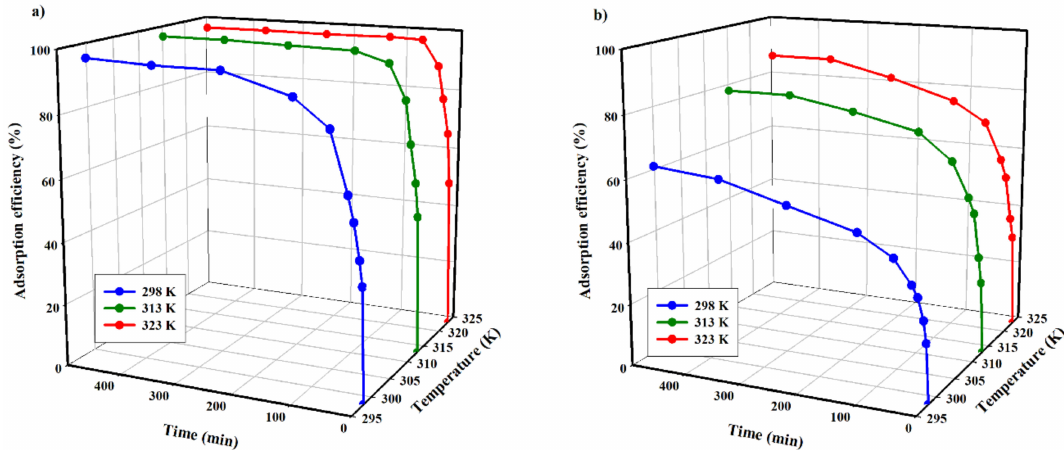
Figure 9. Adsorption efficiency as a function of time and temperature: ( a ) copper(II); ( b ) zinc(II); (c = 100 mg · dm − 3 , mass of adsorbent = 3.33 g · dm − 3 , pH =